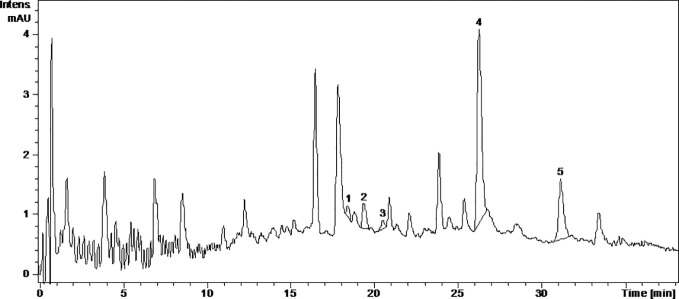
The UV chromatogram of fermented Fetească neagră 2015 grape pomace extract. 1, Hyperoside; 2, Isoquercitrin; 3, Miricetol; 4, Quercetin; 5, Kaempferol.